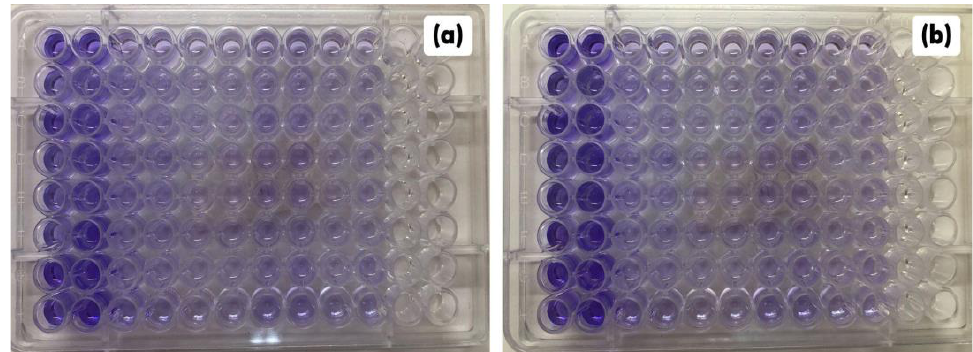
Figure 7. Biofilm biomass stained with violet crystal after experiments of inhibition of biofilm for- mation ( a ) and activity against mature biofilm ( b ) for EOCC, OXA and AMP alone and in combination against the MRSA strain. The first two columns (1 and 2) in ( a , b ) represent the biomass of untreated biofilm; the columns 3 to 10 are the treatments with EOCC and the combinations with OXA and AMP.